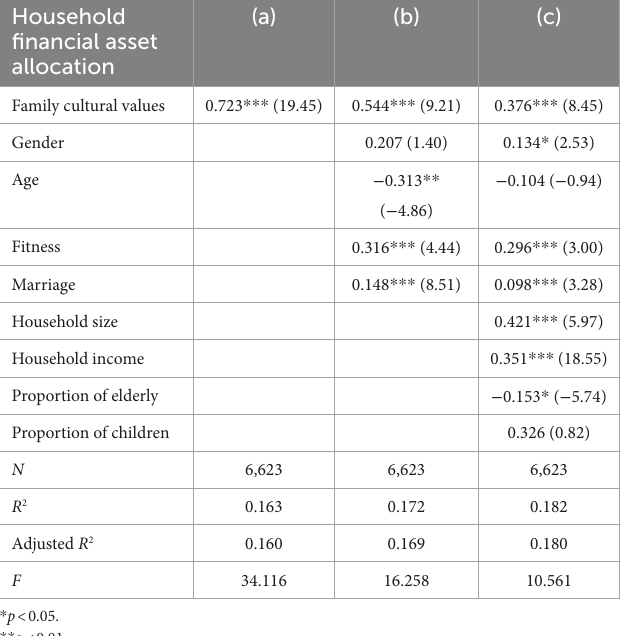
TABLE 2 Regression results of family cultural values on household financial asset allocation. Household financial